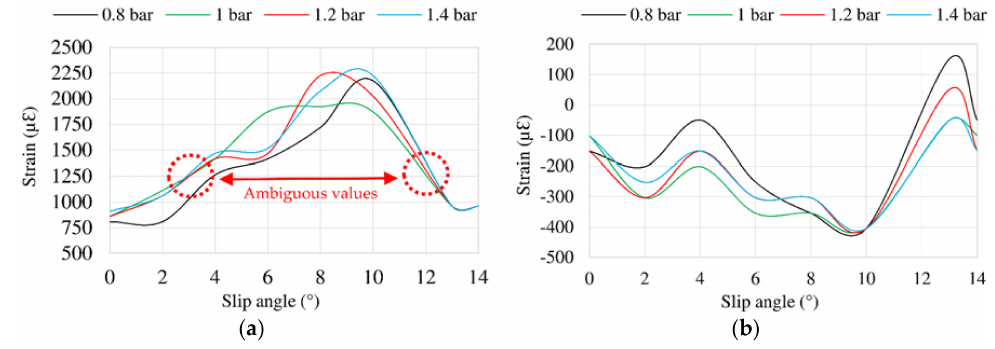
Figure 12. ( a ) Offset values in channel 2 ( ε x ) at 750 N, 50 km/h; ( b ) Offset values in channel 3 ( ε y1 ) at 750 N, 50 km/h.